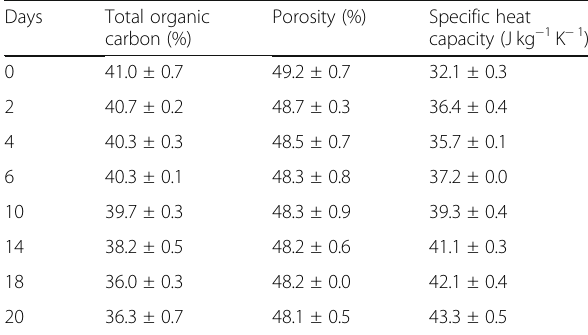
Table 3 Variation in total organic carbon, porosity and specific heat capacity throughout composting